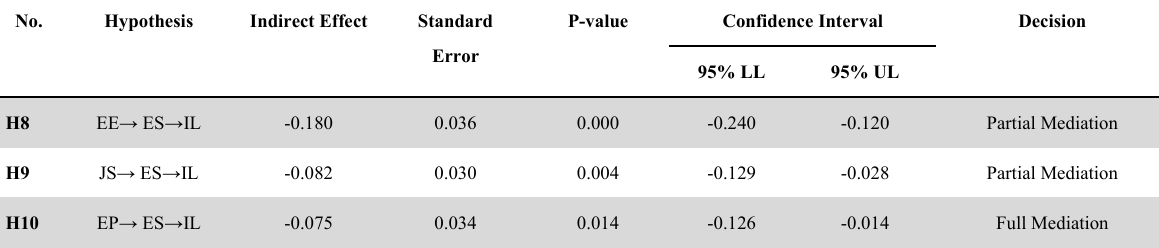
Testing the Mediating Effect of Employees’